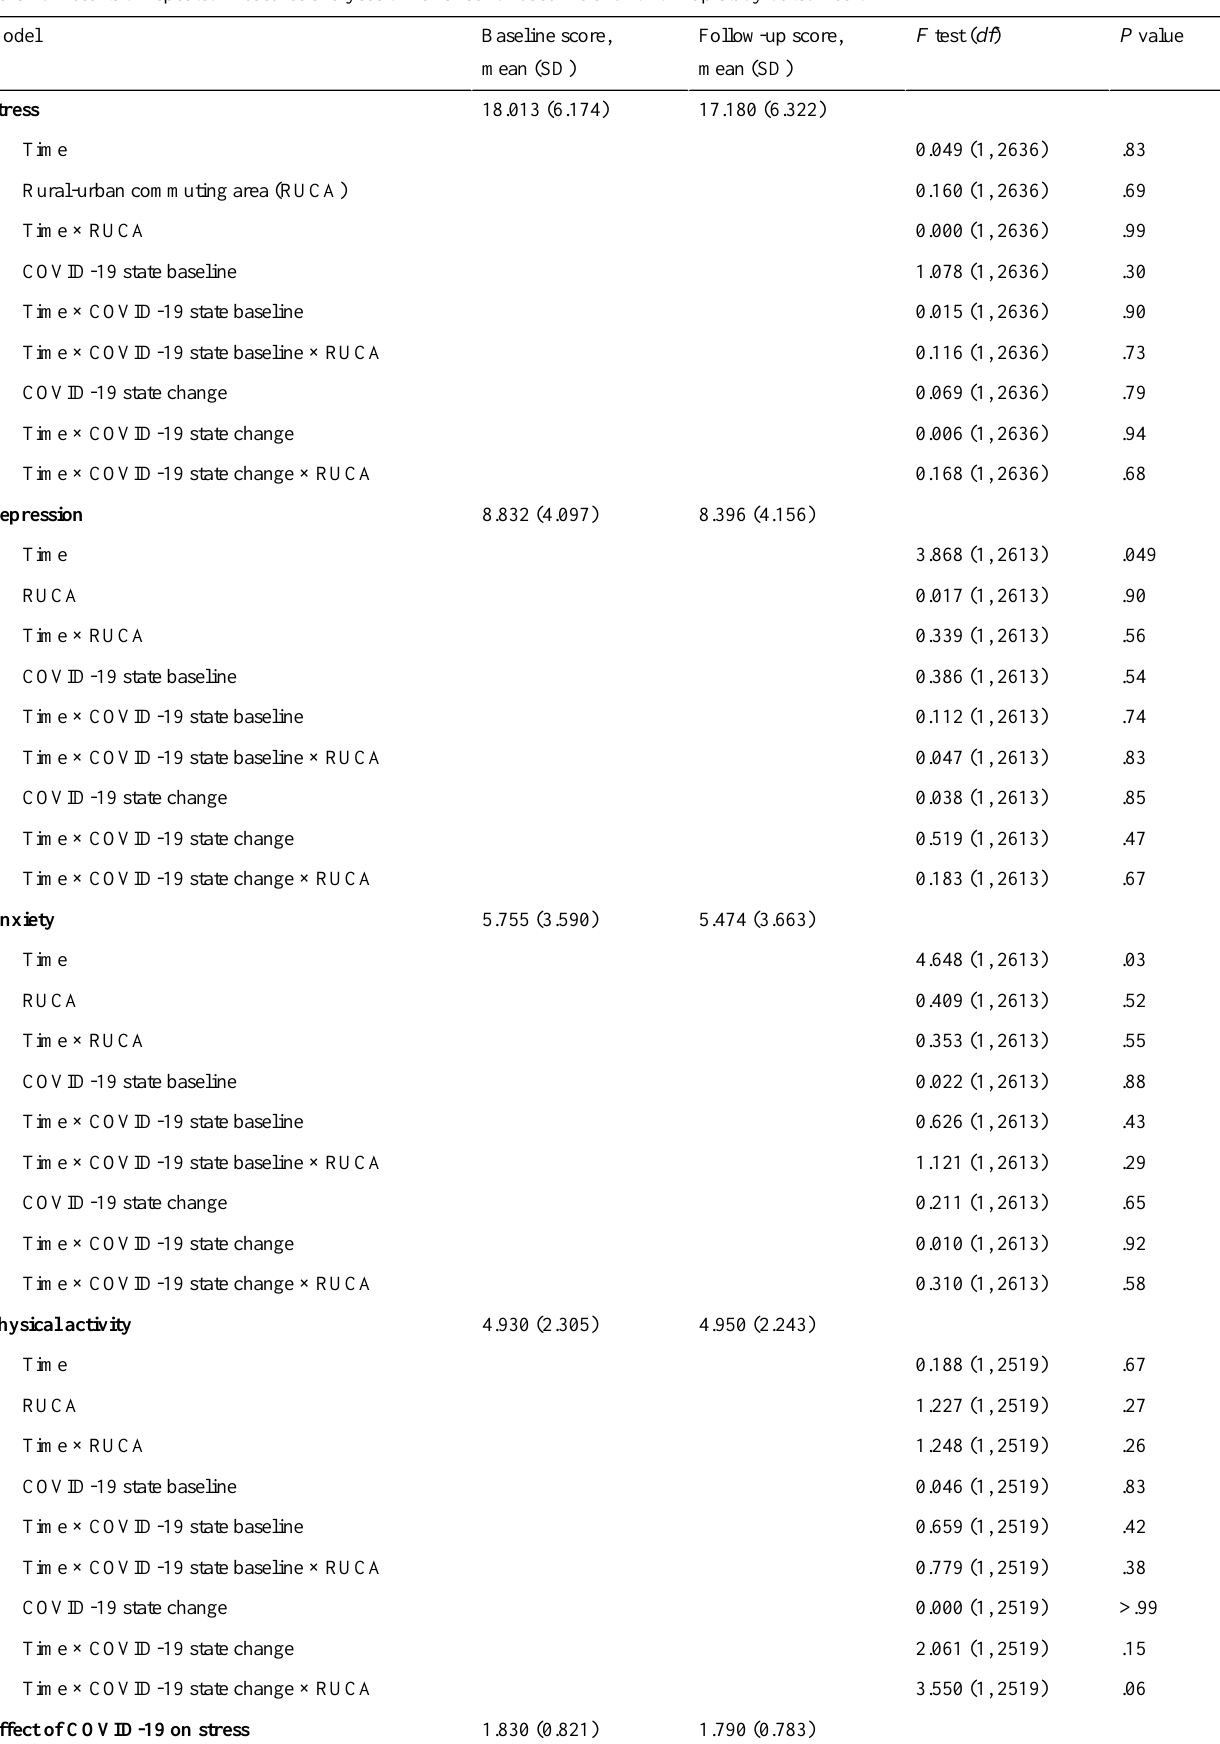
Table 4. Results of repeated-measures analyses of variance for baseline and follow-up study outcomes a .